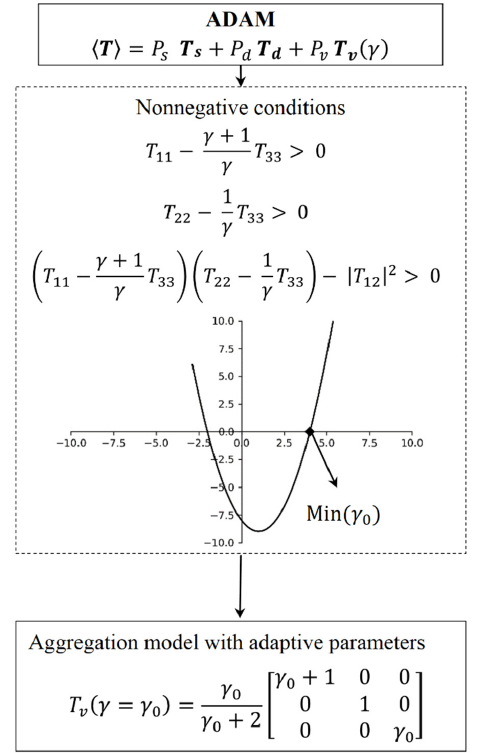
Figure 4. Determination of the adaptive parameter in the dipole aggregation model.